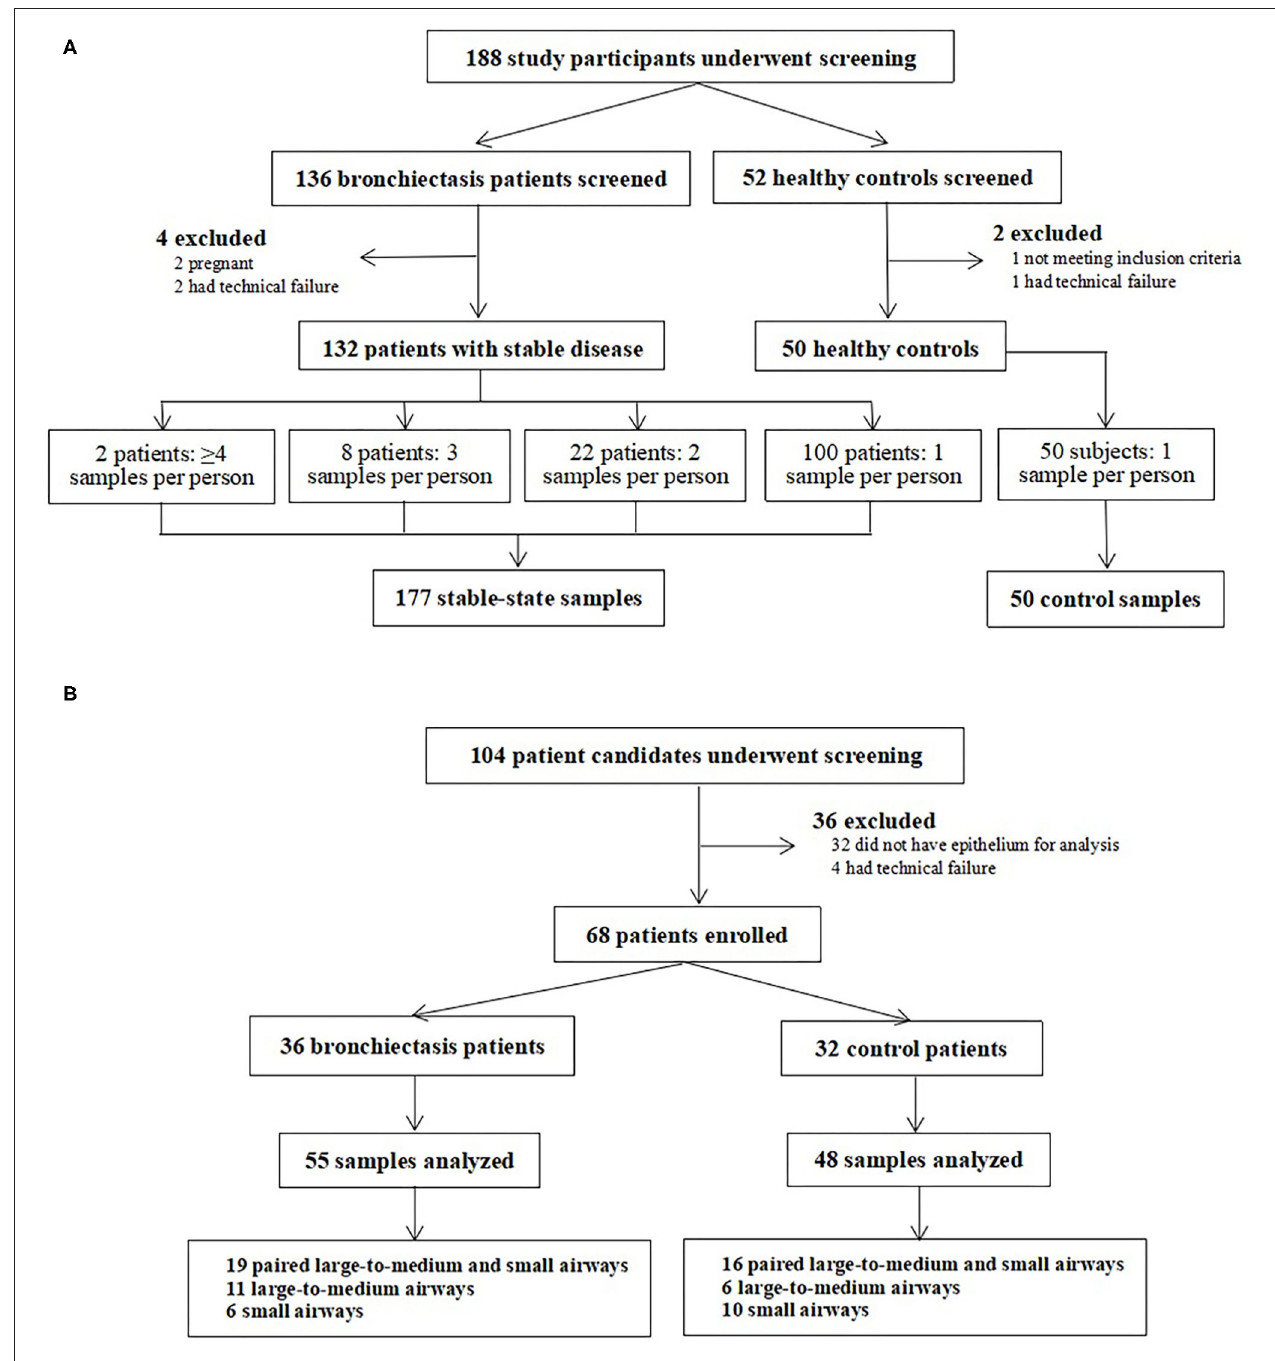
FIGURE 1 | Recruitment flowchart of the study participants. (A) presents recruitment flowchart of the study participants for Study 1, where patients with clinically stable and exacerbation (in a subgroup of patients) of bronchiectasis as well as the healthy controls were included. (B) displays recruitment flowchart of the study participants for Study 2, where patients with bronchiectasis and the disease controls who were scheduled for elective lobectomy or segmentectomy were